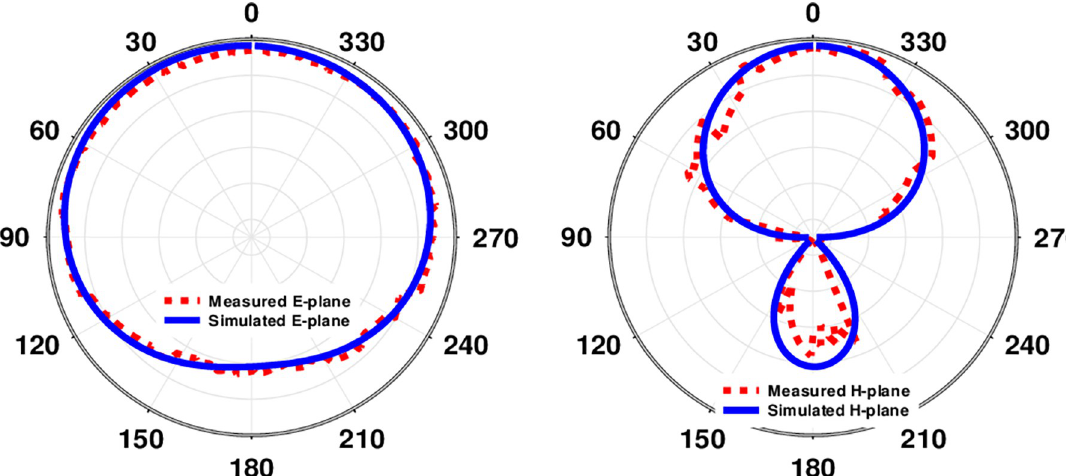
Fig 18. Skin tissue was used to simulate and measure farfield outcomes at a frequency of 2.45